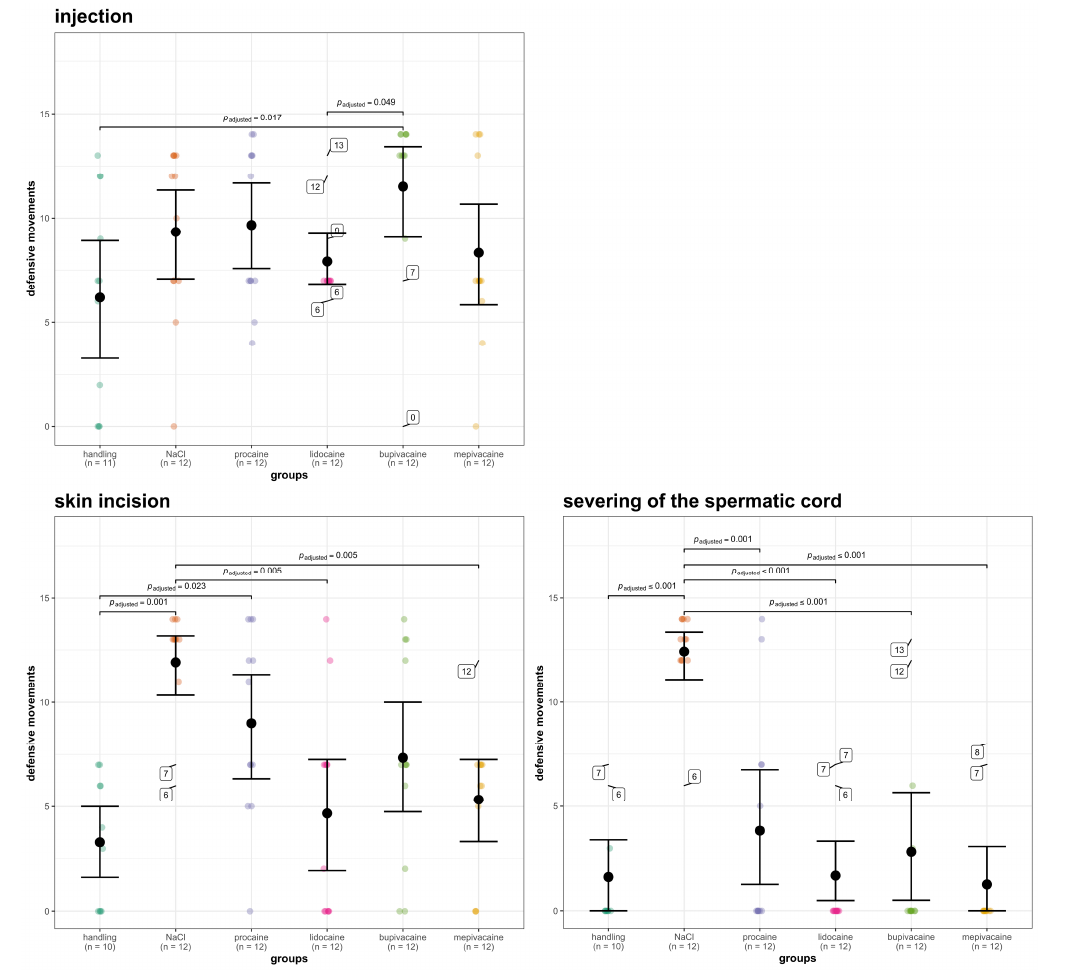
Figure 2. Mean values, confidence intervals and p -values of the score used to evaluate the defensive movements in different groups during injection, skin incision and severing of the spermatic cord; outliers were calculated using Tukey´s method and were tagged on the picture with a value instead of the data point to avoid clutter.